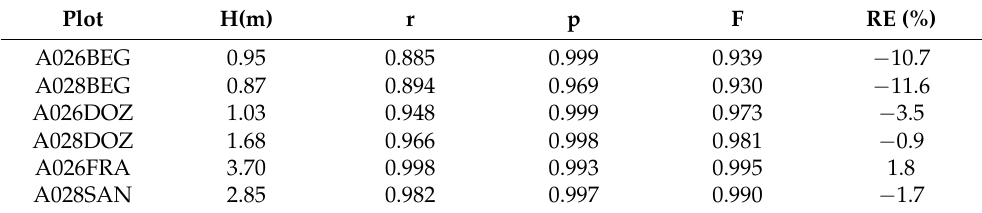
Table 5. Evaluation of the ITD in terms of statistical measures for the case of the results obtained with the Dalponte and Coomes [42] algorithm (H(m) is mean height of the trees in the plot, r is recall, p is precision, F is overall precision and RE is relative